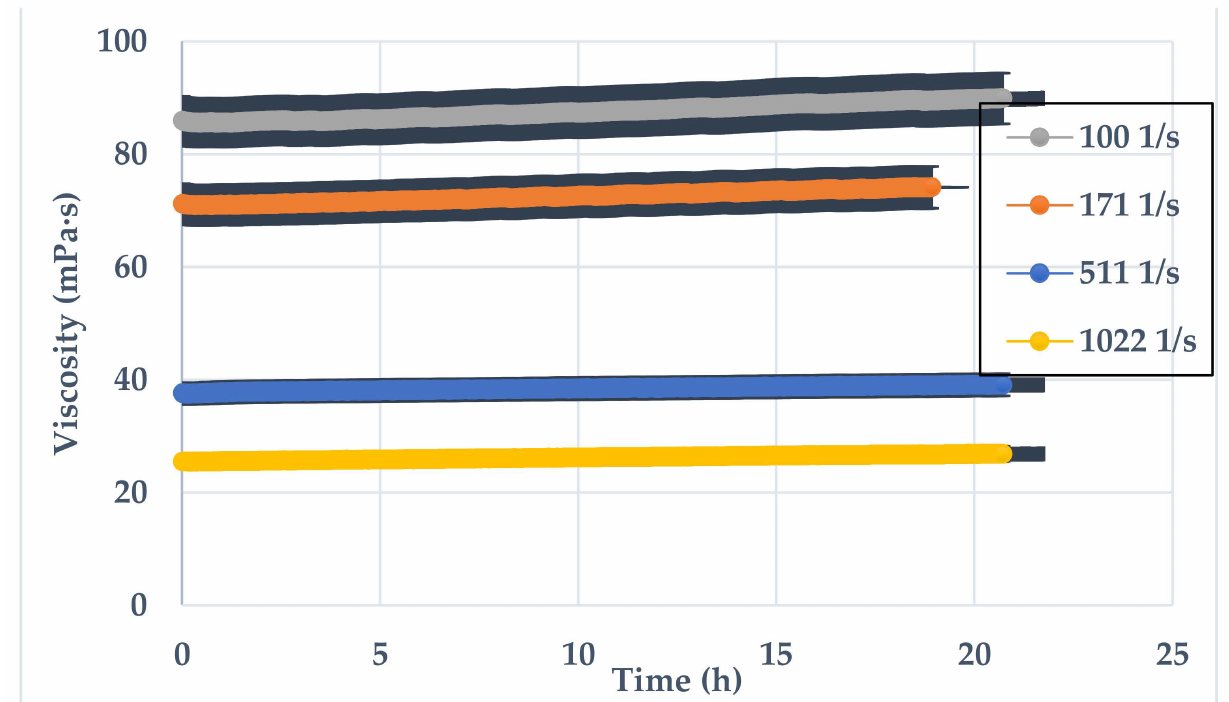
Figure 10. SW-based viscosity versus time, 0.5 wt% CMHPG polymer 10 vol% of GLDA with (pH = 8.85) at standard conditions and different shear